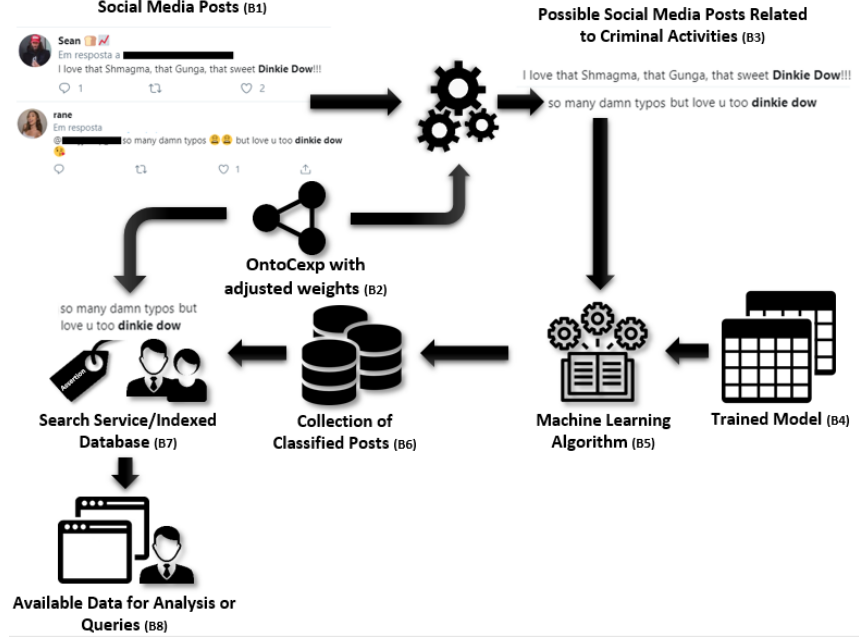
Figure 4. Key steps in the phrase selection and